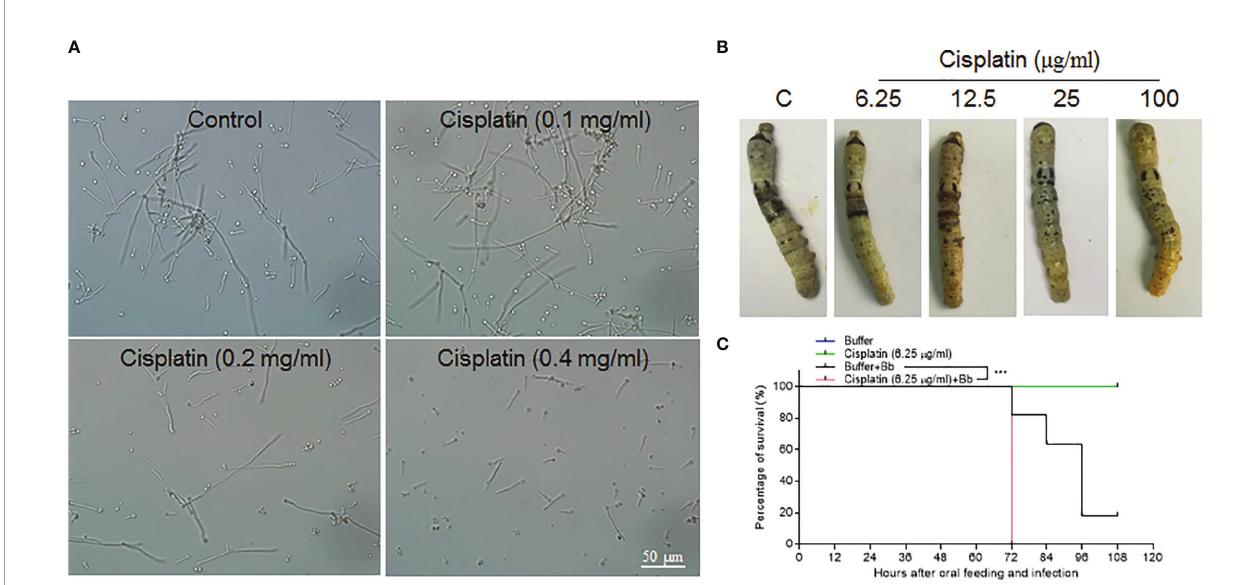
FIGURE 7 | Epidermis cell proliferation is an important host response against B. bassiana infection. Due to lacking effective genetic manipulation to inhibit epidermis cell proliferation, Cisplatin, the inhibitor of cell DNA duplication and division (21, 22), was fed to larvae that received the fi xed-site infection or not. (A) Screening to determine a proper concentration of Cisplatin that did not affect B. bassiana conidia germination and growth. Cisplatin <0.1 mg/ml did not impact B. bassiana growth. (B) Screening to determine a suitable concentration of Cisplatin that does not affect melanization after the fi xed-site infection for 48 h. Ultimately, it was determined that 6.25 µg/ml of Cisplatin did not interrupt B. bassiana (indicated as Bb in the graph) development and integument melanization and this amount was spread on mulberry leaves to feed to larvae after the fi xed-site infection. (C) Bioassay after the fi xed-site infection with or without Cisplatin fed to inhibit epidermis cell proliferation. Cisplatin (6.25 µg/ml) fed to larvae without fungal infection did not induce any death. After the fi xed-site infection, Cisplatin feeding signi fi cantly increased B. bassiana virulence with most larvae dying at 72 h after infection. Without Cisplatin feeding, infected larvae lived a signi fi cantly longer time. Kaplan-Meier survival curves were compared using the log-rank (Mantel-Cox) test after the fi xed infection among with Cisplatin involved or not (***p =